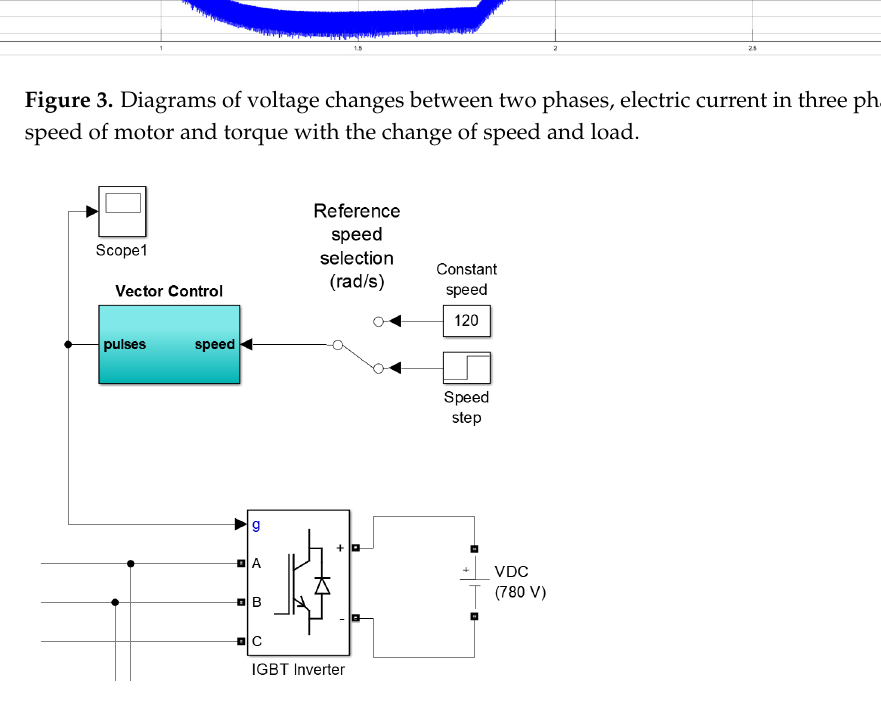
Figure 3. Diagrams of voltage changes between two phases, electric current in three phases, angular speed of motor and torque with the change of speed and load.